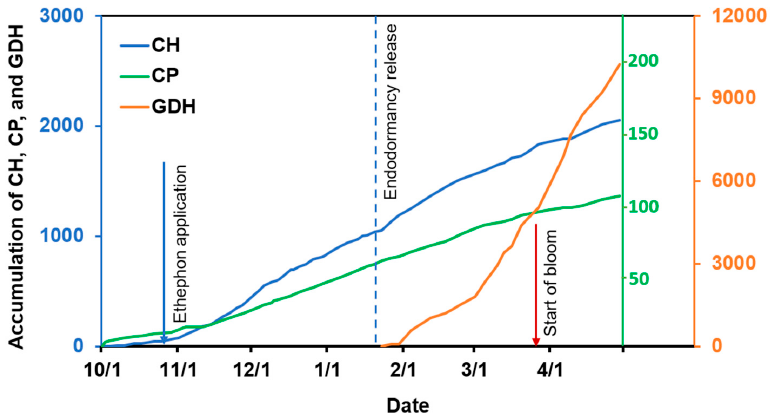
Figure 1. Accumulation of chilling hours (CH), chilling portions (CP), and growing degree hours (GDH) in the ‘Redhaven’ orchard. Major events are indicated with arrows. CH accumulation began on 7 October